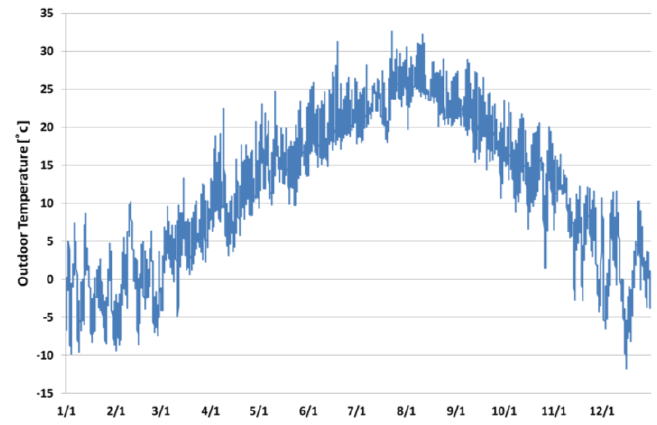
Figure 5. Outdoor air temperature of Incheon City.